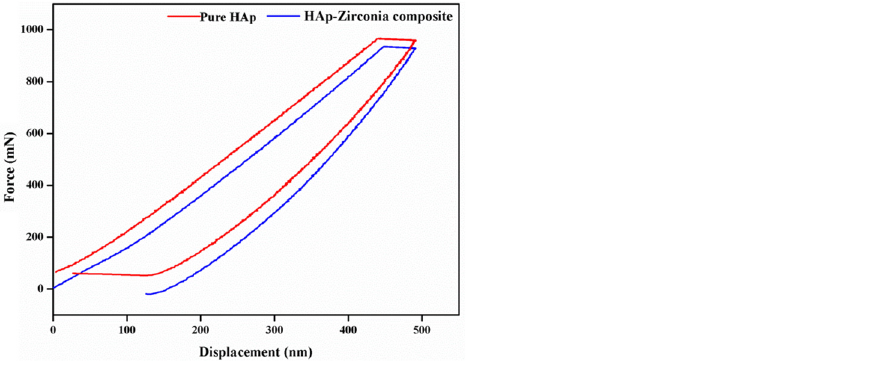
Figure 5. The force-displacement curve of pure HAp and the HAp-Zirconia (HZ1) composite.